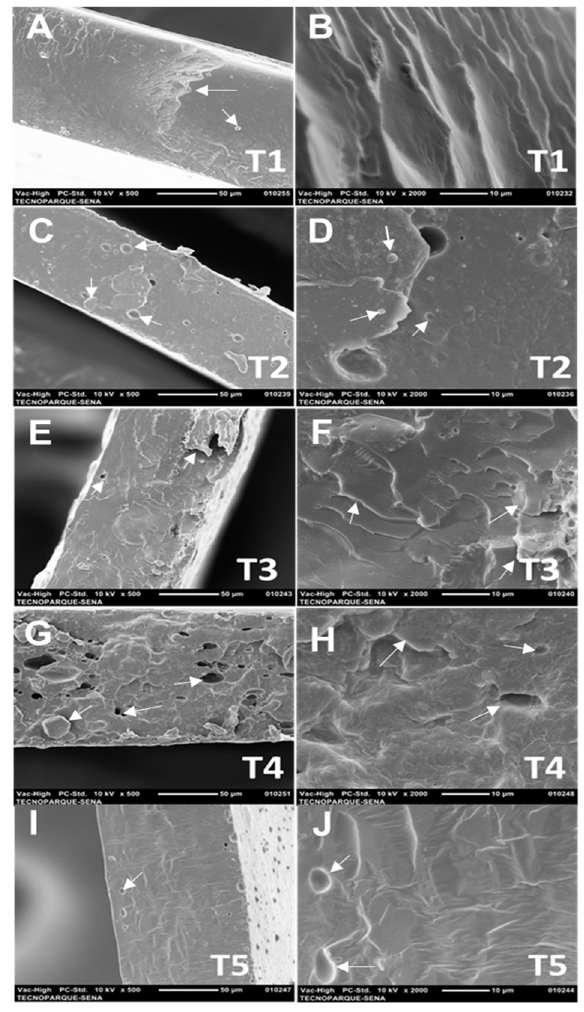
Figure 4. Morphological analysis of the composite’s membranes cross-section. T1 (100%CS) ( A ) 500 × ( B ) 2000 × ; T2 (25%G:75%CS) ( C ) 500 × ( D ) 2000 × ; T3 (50%G:50%CS) ( E ) 500 × ( F ) 2000 × ; T4 (75%G:25%CS) ( G ) 500 × ( H ) 2000 × ; T5 (100%G) ( I ) 500 × ( J ) 2000 ×